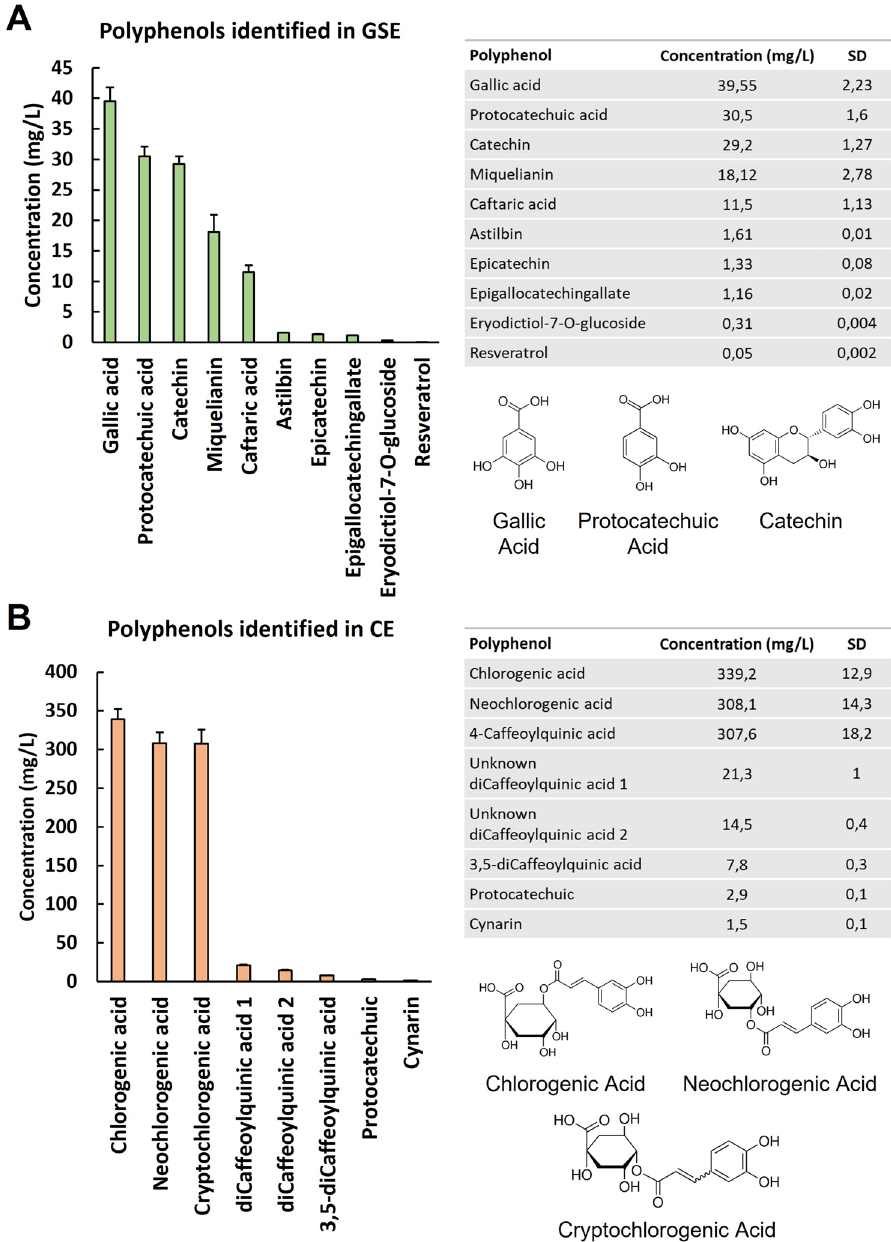
Figure 1. Quantification of phenolic compounds in GSE ( A ) and CE ( B ) by HPLC . The results are presented as a histogram and values data table. Quantification of each polyphenol identified in both extracts was performed in triplicate, and all values are presented as the mean ± SD (n = 3). The molecular structures of the major compounds in both extracts are also